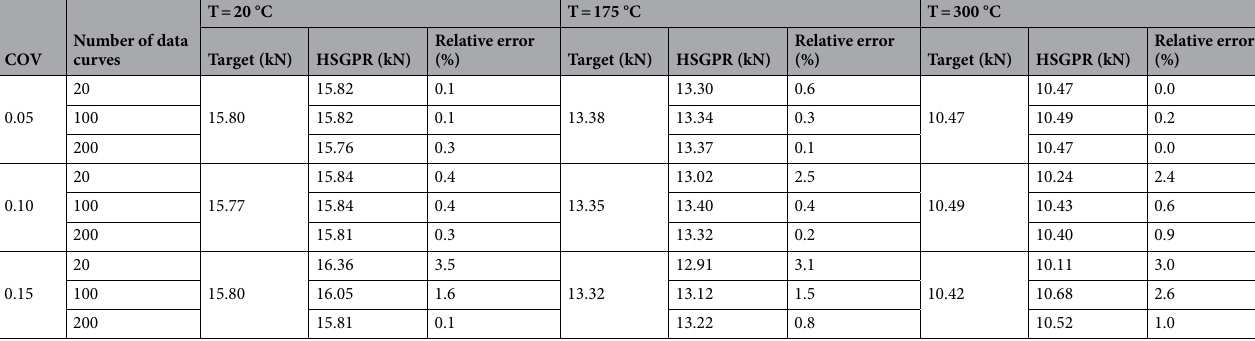
Table 6. The expectation of the structural capacity given by the HSGPR-based flow stress model and the target model at different dataset sizes, temperatures and coefficient of variation (COV).